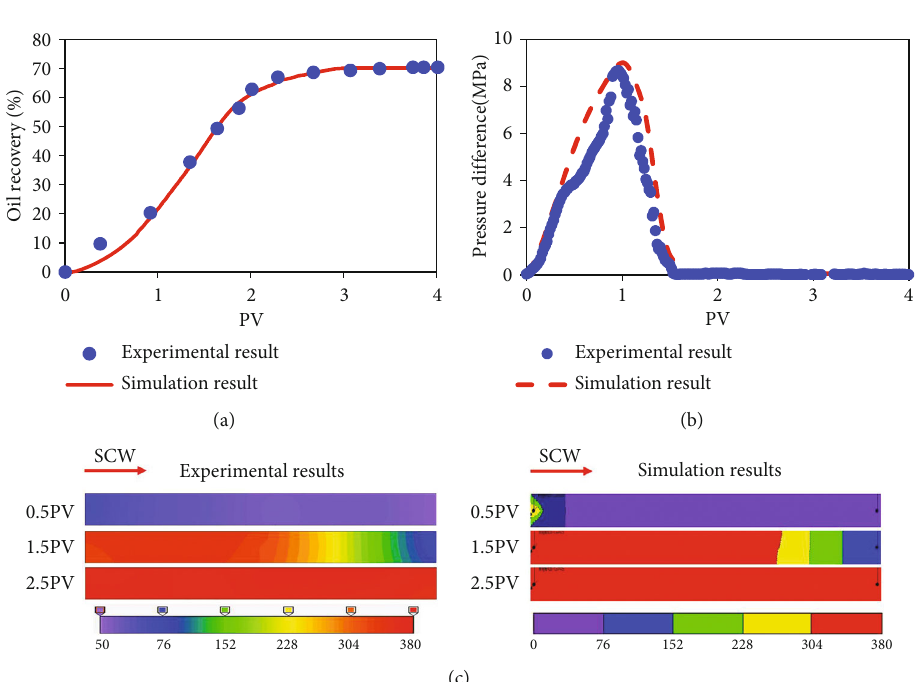
Figure 8: Comparison of simulation and experimental results of SCW fl ooding: (a) oil recovery, (b) pressure di ff erence, and (c) temperature distributions.